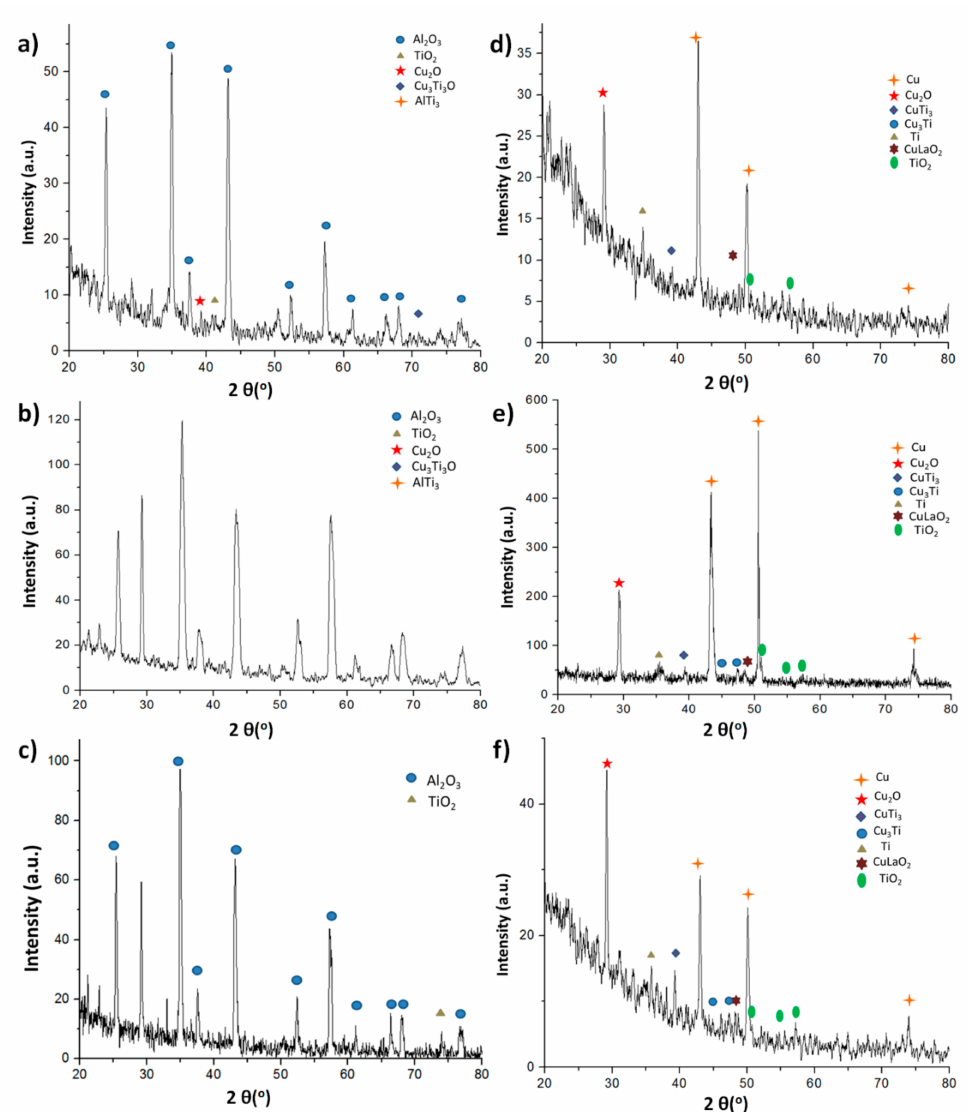
Figure 6. XRD analysis of fracture surface of alumina substrate side bonded at ( a ) 250 ◦ C, ( b ) 300 ◦ C, and ( c ) 350 ◦ C; fracture surfaces of copper side bonded at ( d ) 250 ◦ C, ( e ) 300 ◦ C, and ( f ) 350 ◦ C